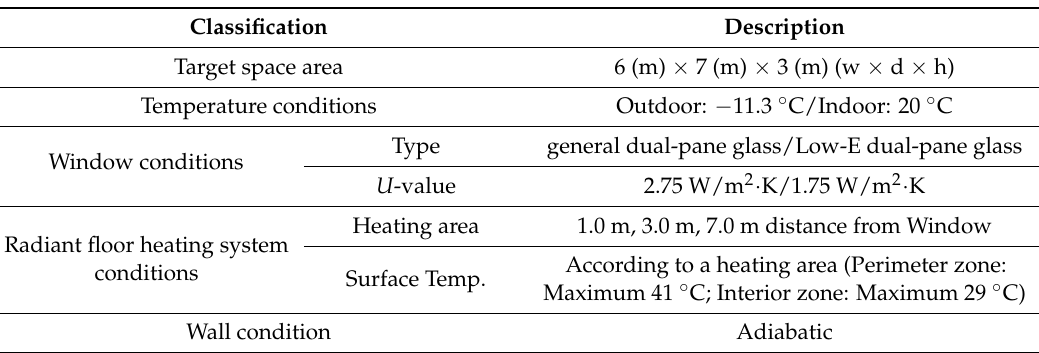
Table 2. Conditions of target space.